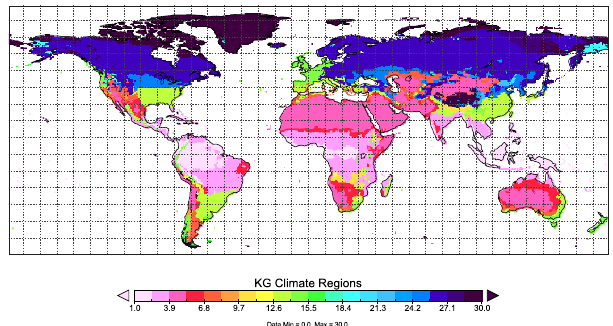
Figure 5. Example of a global Köppen–Geiger climate classifica-